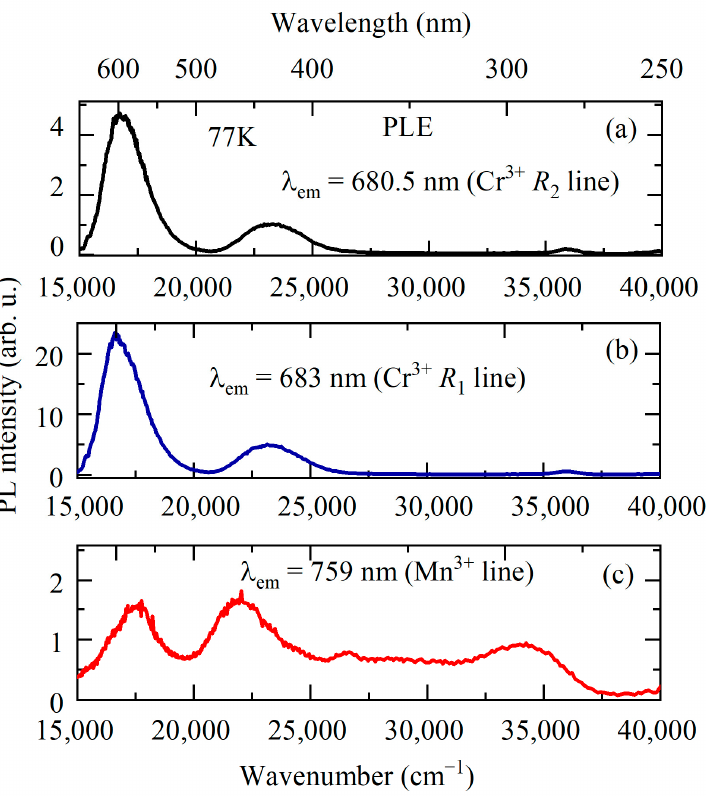
Figure 7. Unpolarized absorption spectra of YAB:Mn at different temperatures in the spectral range of zero-phonon R lines. The inset shows the spectra at T = 5 K for two polarization directions of the incident light: E|| c (red trace) and E ⊥ c (blue trace) ( a ). Absorption spectrum at T = 5 K in the region of the 4 A 2 → 2 T 1 transition ( b ).